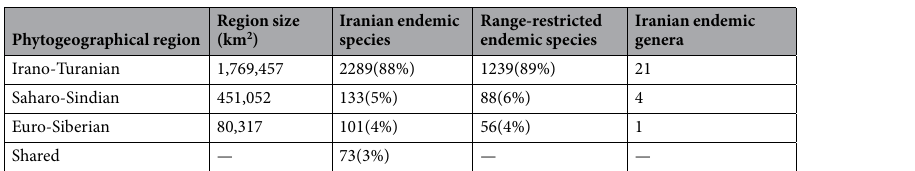
Region size (km 2 )